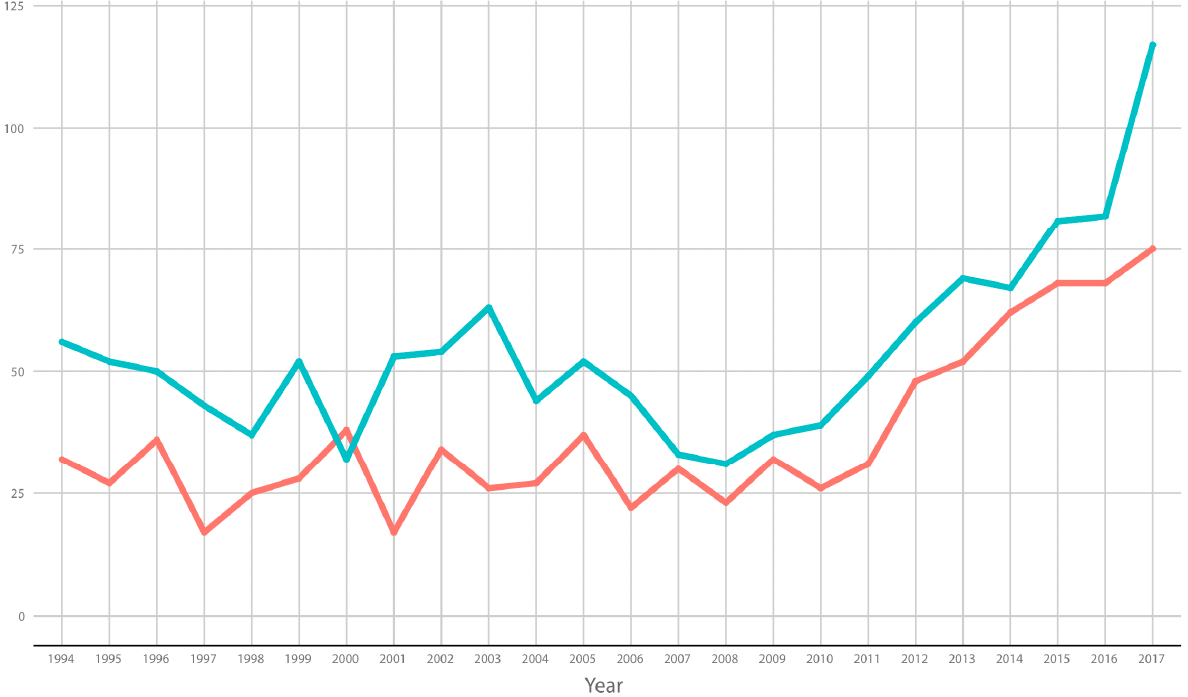
Figure 1. Yearly incidence in patients with onychomycosis treated in Danish hospitals. The blue line illustrates the incidence in men, while the red line illustrates the incidence in women. The available data from 2018 only included the first quarter of the year, and therefore this year’s data have been removed from the graph.